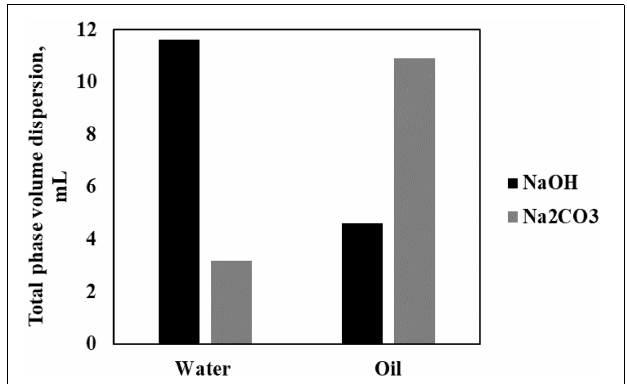
FIGURE 6 | Total volume of water and oil distribution from orthogonal bottle